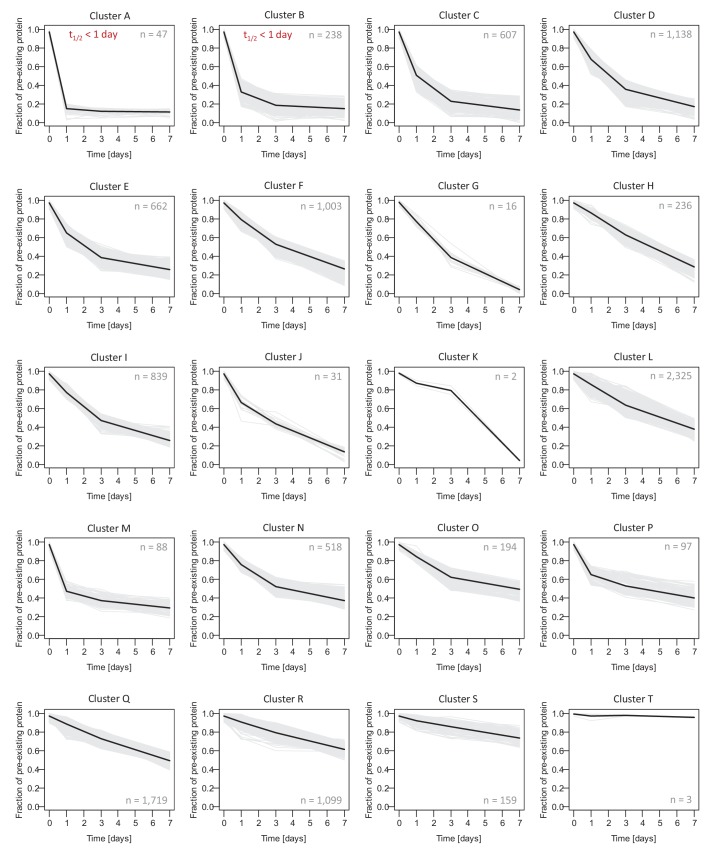
Protein decay clusters.The decay curves of all protein groups (from mixed, neuron-enriched and glia-enriched cultures) were assigned to one of 20 clusters using hierarchical clustering (K-Means method). Decay curves for individual protein groups are shown as grey lines, and the average decay behavior for each cluster is shown as bold black line. Proteins groups assigned to cluster 6 and 7 are excluded from half-life determination, since most of the pre-existing proteins was degraded already after 1 day resulting in inaccurate exponential fitting. For down-stream analysis, these proteins were assigned a half-life <1 day. Protein groups in cluster 20 are long-lived proteins. Due to the minimum changes during the measurement time course of 7 days, their half-lives (determined by exponential fitting) are only rough estimates.